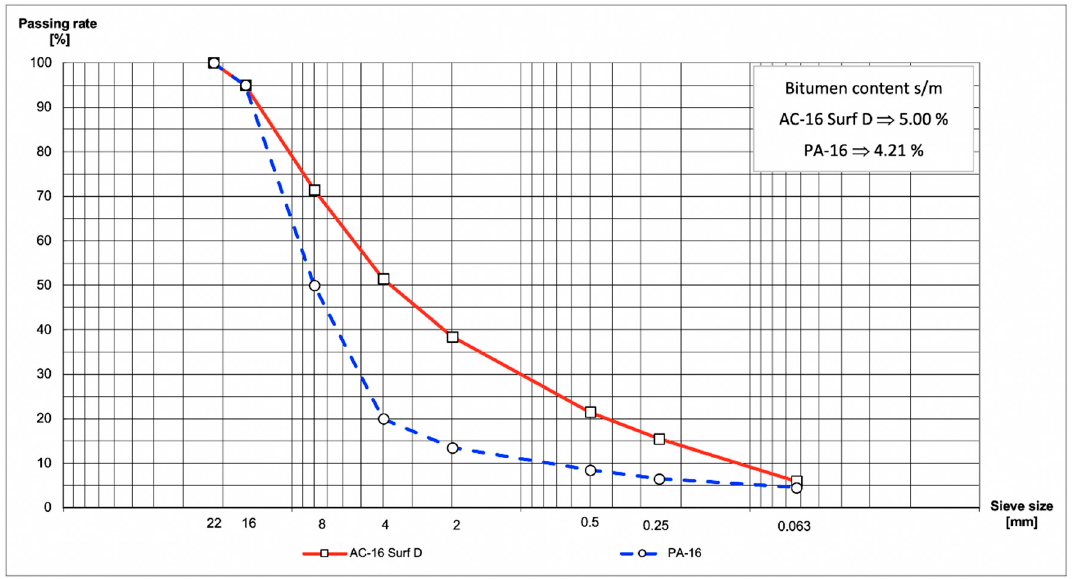
Figure 1. Particle size and asphalt content of bituminous mixture.